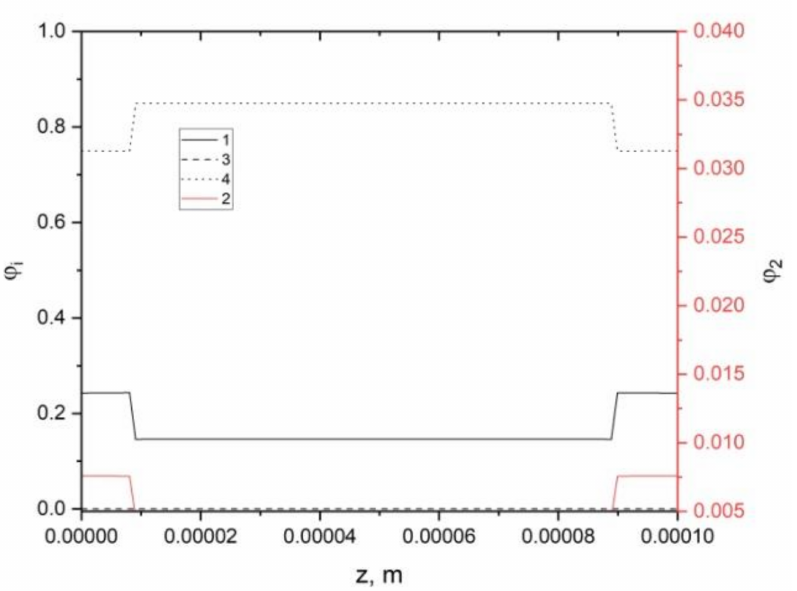
Figure 9. Distribution of volume fractions of phases under the influence of a low-intensity surface forest fire depending on the thickness of the leaf at time t = 5 s (spring, April, +6 ◦ C, ϕ 30 = 0.4,